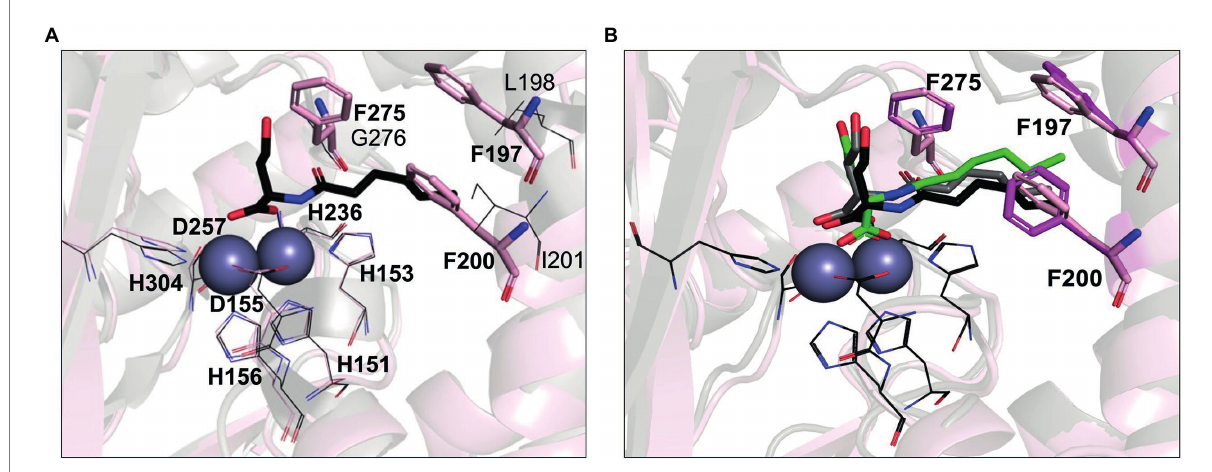
FIGURE 4 Computational AHL binding analysis. (A) The binding pocket of LrsL (light pink cartoon) is superimposed on AidC (PDB 4zo3; gray). The unique phenylalanine residues in the active site of LrsL are shown as light pink stick models. The corresponding AidC residues (leucine, isoleucine and glycine) are shown as dark gray lines. Conserved zinc coordination residues for LrsL (light pink lines) and AidC (black lines) are shown. Zinc ions are shown as blue-gray spheres. (B) Computational docking poses of C6L on AidC and LrsL. The crystallographic structure of the AidC:C6L complex is shown as a black cartoon, with C6L shown as black stick model. The redocked pose of C6L on AidC is represented as gray stick model and the docked pose of C6L on LrsL is shown as green stick model. The phenylalanine residues from the apo-crystal structure of LrsL are shown in light pink sticks, and from the C6L docked model of LrsL as magenta sticks. Conserved zinc coordination residue coloring and labeling corresponds to (A) . Zinc ions are shown are blue-gray spheres.